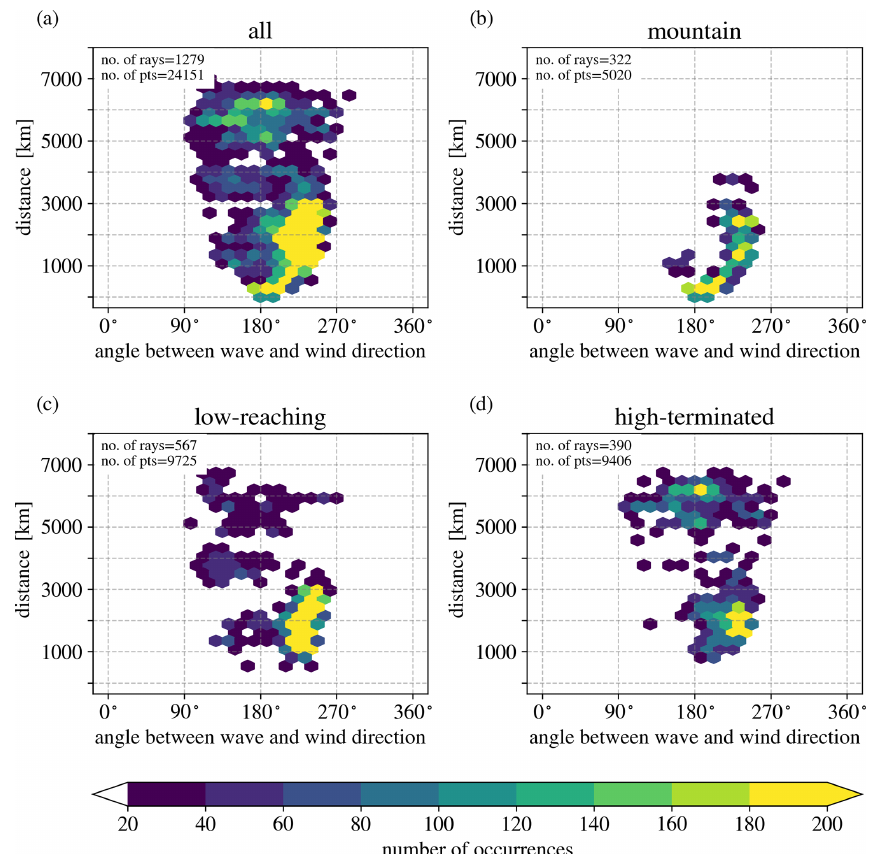
Figure 8. Relation of the relative orientation of the wave to the wind direction and the distance of the corresponding ray from the launch to the termination point. Instances are picked at all ray locations between 6 and 18km altitude to focus on the altitudes where most of the lateral propagation takes place. In the upper-left corner of each panel, the total number of rays (no. of rays) and the total number of instances (no. of pts) are stated. The colour code shows the number of instances in each bin. The 180 ◦ label indicates an opposite orientation, and the difference angle is anticlockwise with respect to the wind